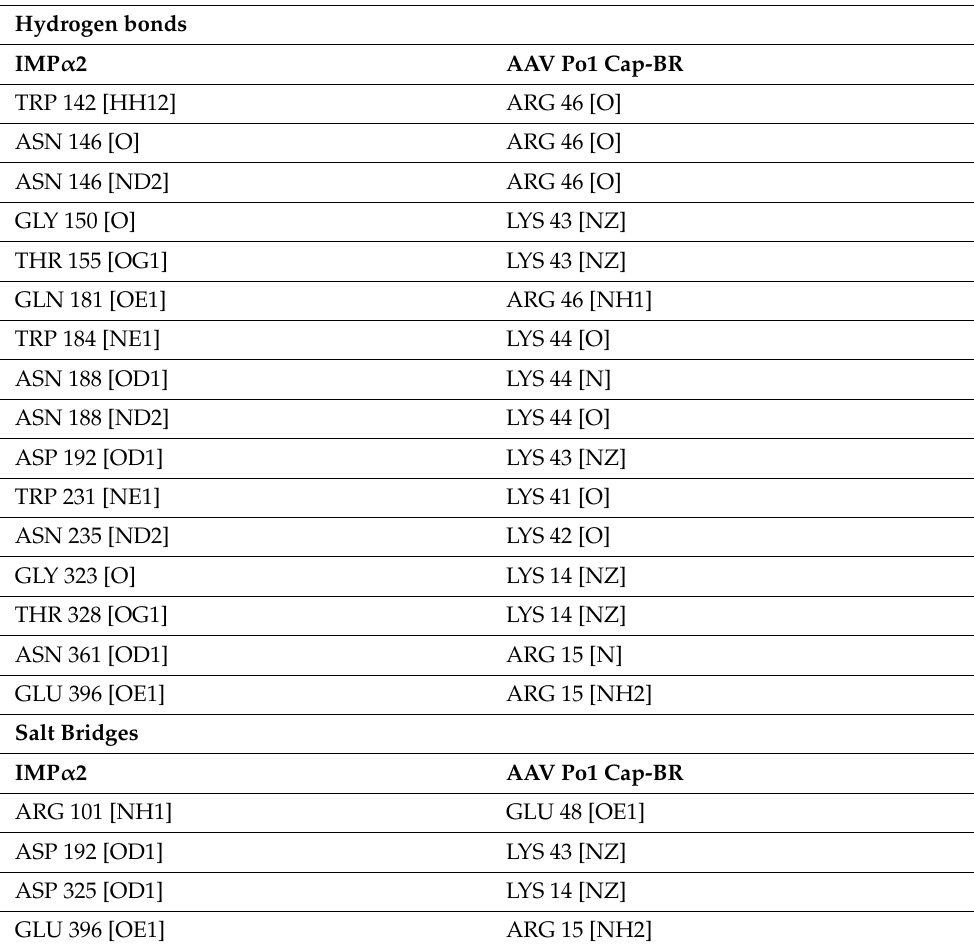
Table 2. Hydrogen bond and salt bridge